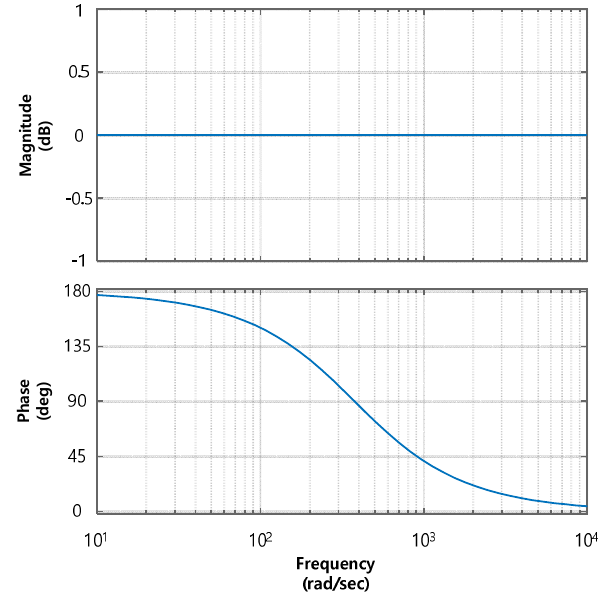
Figure 4. Bode plot of the all-pass filter: ω = 377 (rad/s).